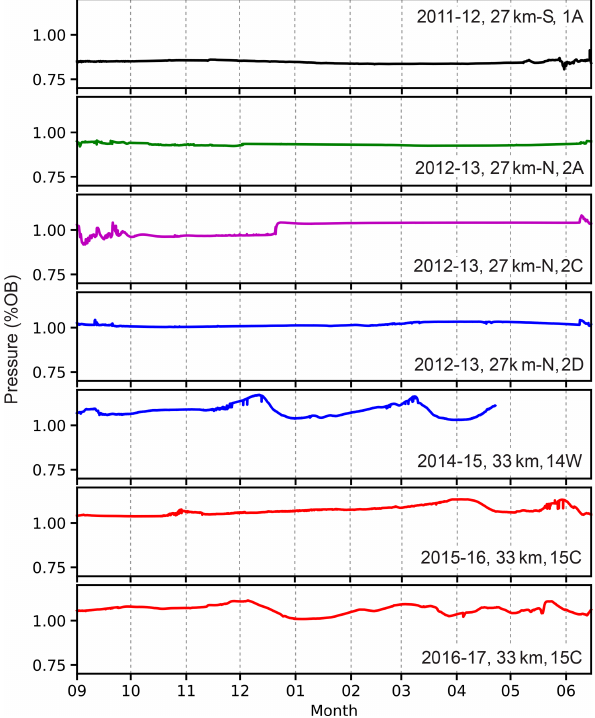
Figure 5. Basal water pressure measured in boreholes centered on selected winters. Year, location as distance (km) from the terminus, and borehole name are shown on the right side of each panel.